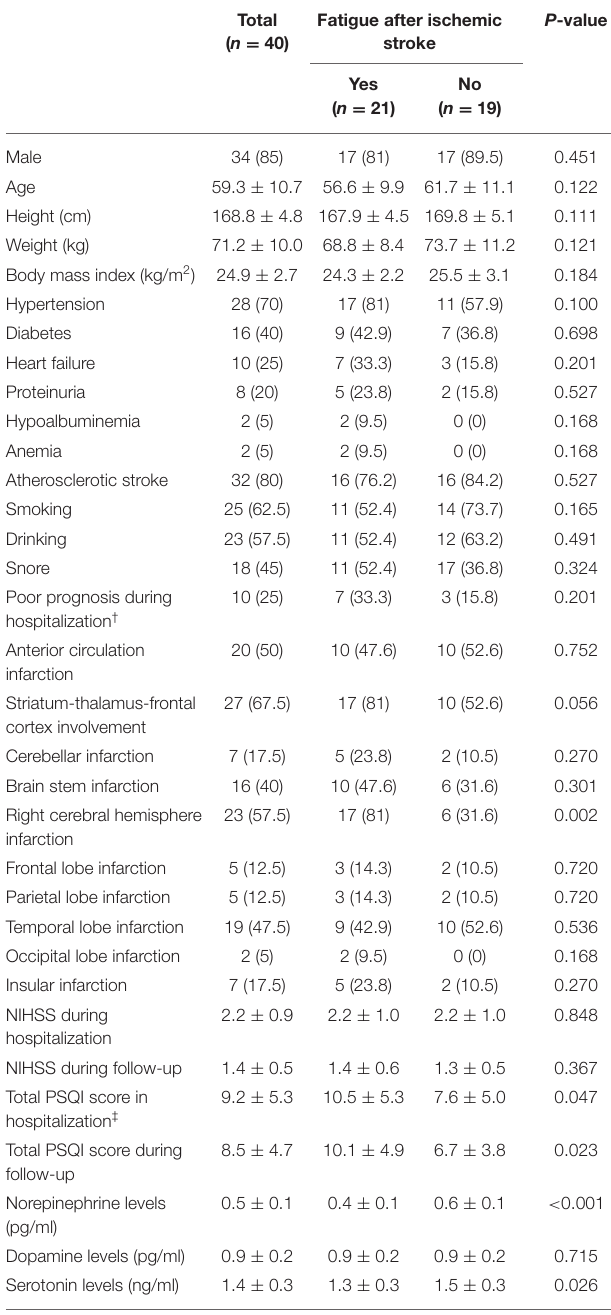
TABLE 1 | Demographic and clinical variables during hospitalization and follow-up.